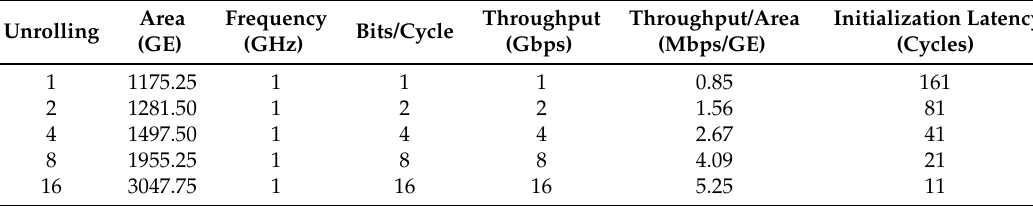
Table 6. Grain-80 synthesis results (65 nm).